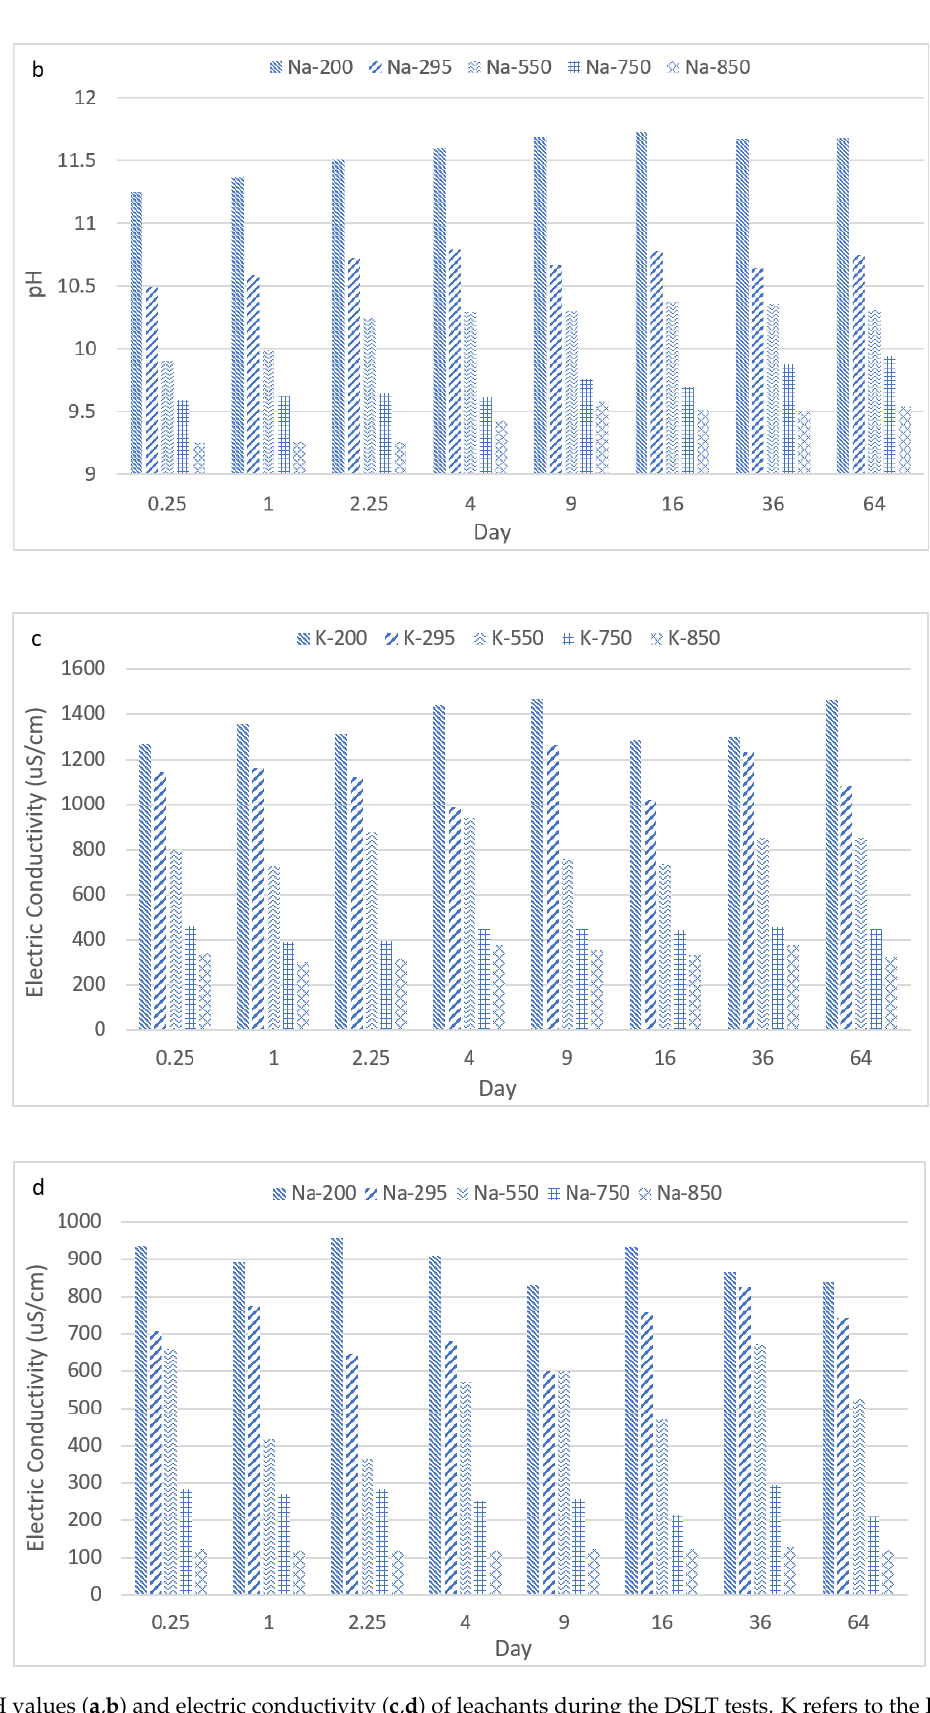
Figure 12. pH values ( a , b ) and electric conductivity ( c , d ) of leachants during the DSLT tests. K refers to the K1 liquid used in Phase